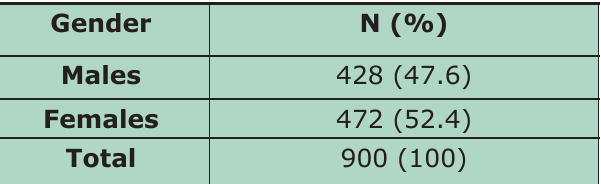
Table-I: Gender distribution of the sample.